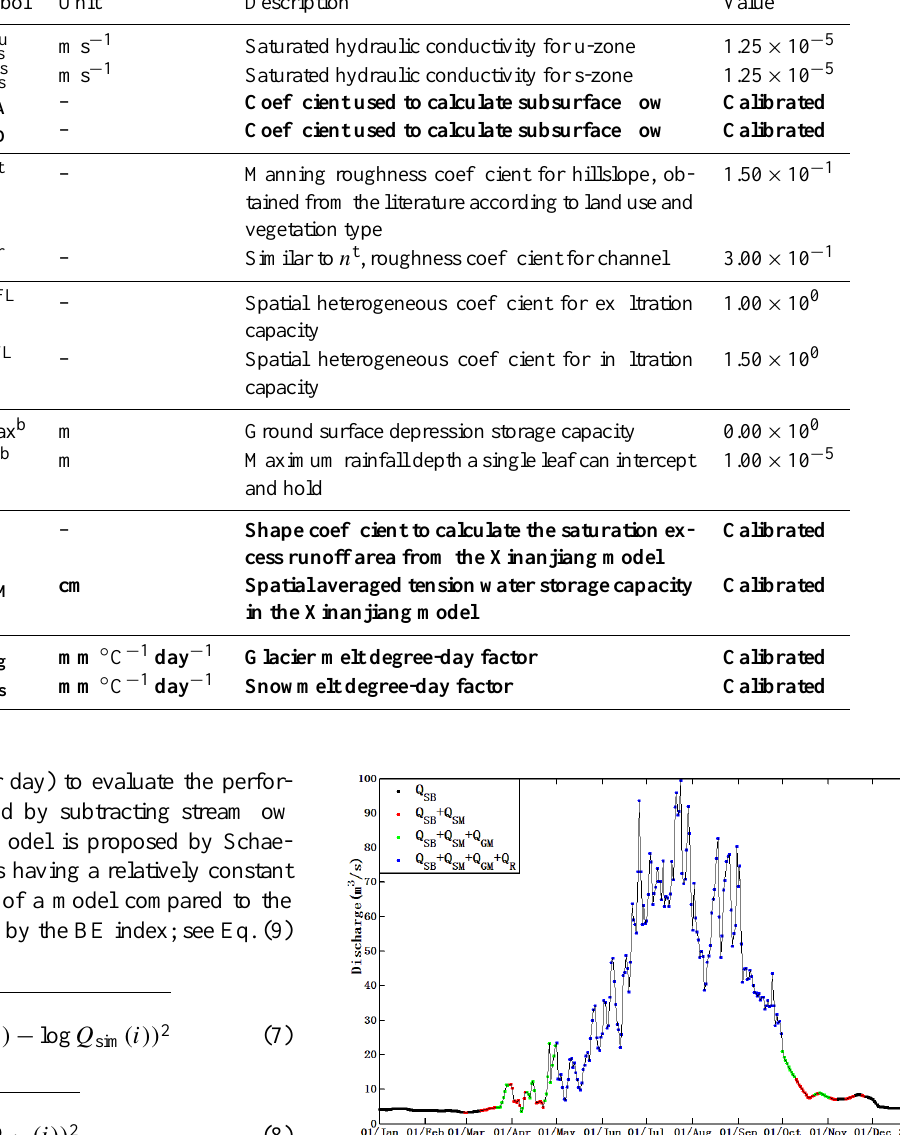
Figure 6. Hydrograph partition in 2003. Q SB stands for subsur- face baseflow generated by groundwater, Q SM and Q GM for snow meltwater and glacier meltwater, respectively, and Q R for rainwater direct